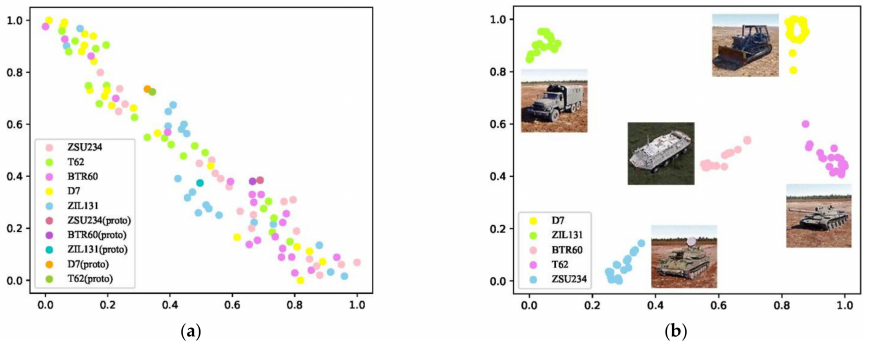
Figure 5. Visualization of clustering effect of ( a ) the prototype network and ( b ) the proposed